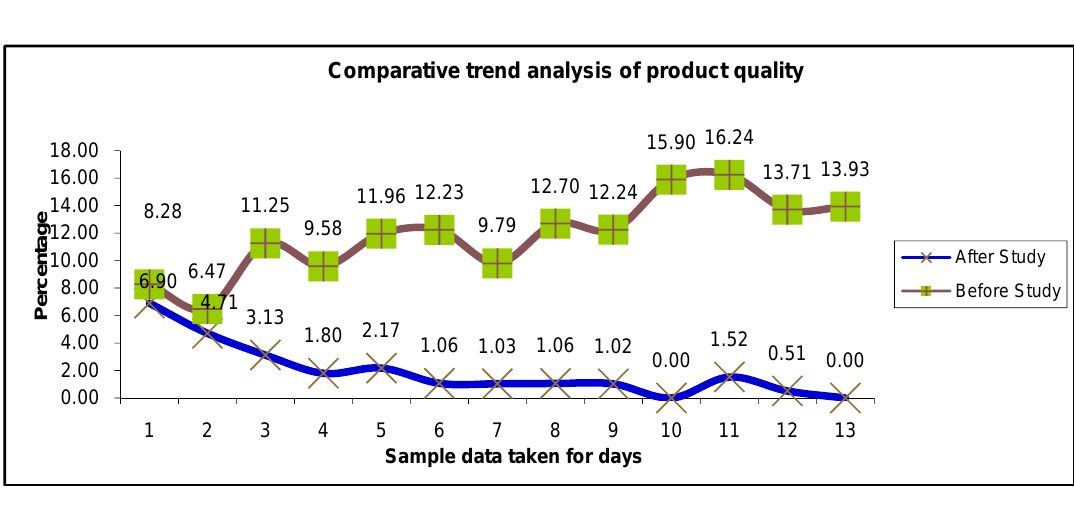
Figure 6. “Comparative trend analysis of cutting products before after Root Cause